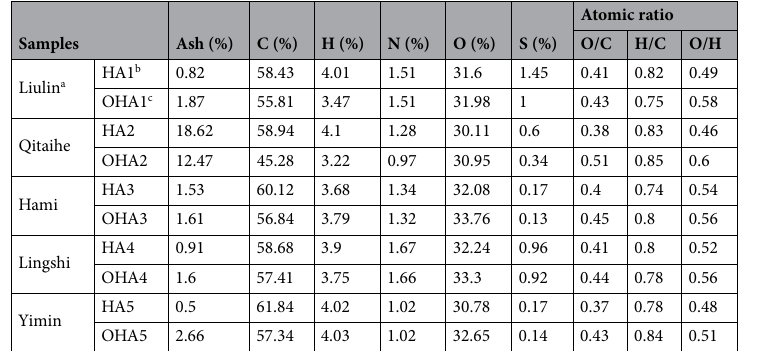
Table 1. Ash content, elemental composition and atomic ratio of HAs. a The location of coal. b The HAs extracted from original coal. c The HAs extracted from oxidized coal.